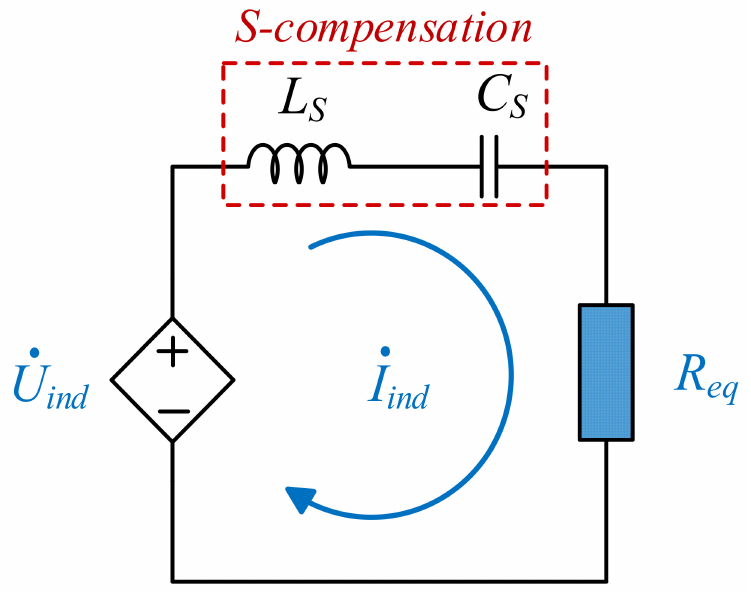
Figure 7. The equivalent circuit at the secondary side with S-compensation network.